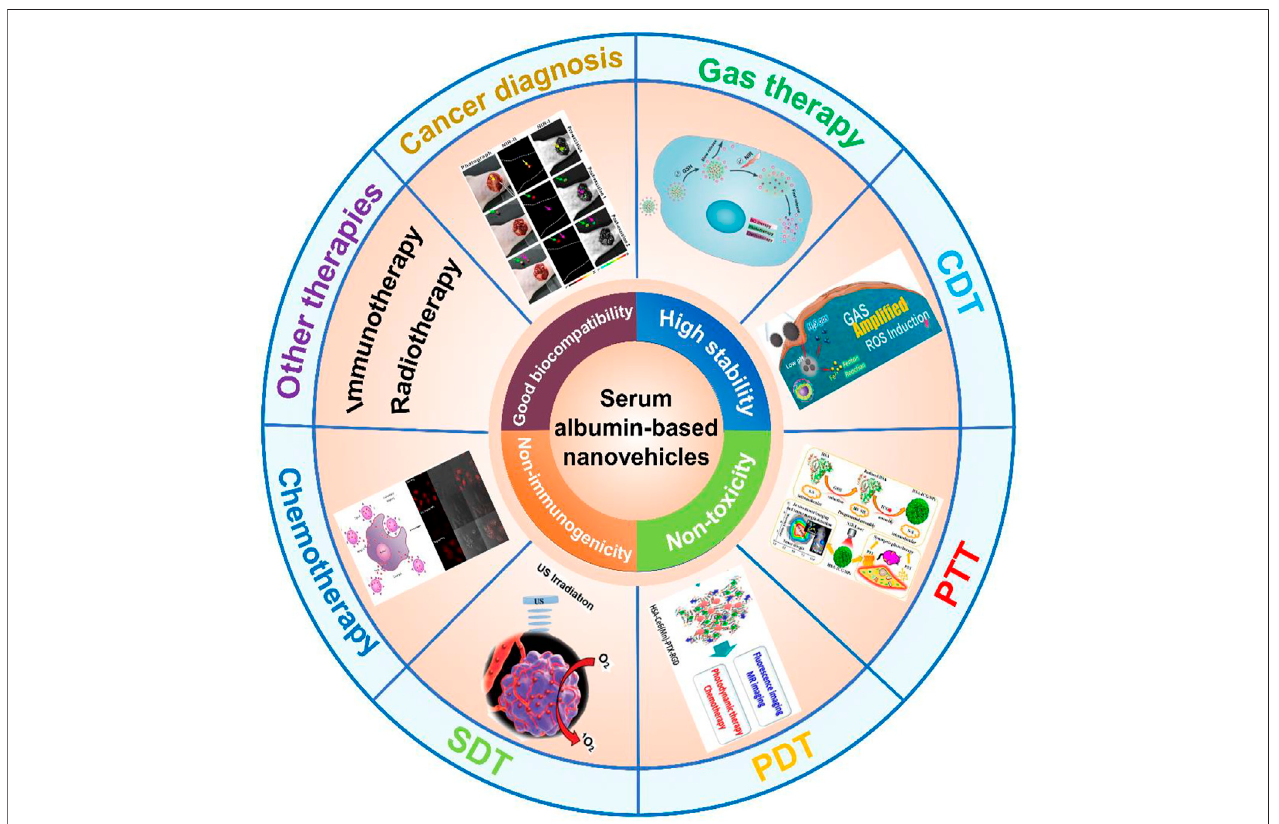
FIGURE 1 | The application of serum albumin-based nanovehicles in cancer diagnosis and therapy. Image for gas therapy: Reproduced with permission from Xu etal.(2019).Copyright2019,RoyalSocietyofChemistry.ImageforCDT:ReproducedwithpermissionfromXieetal.(2020).Copyright2020,WILEY-VCHVerlagGmbH and Co. KGaA, Weinheim. Image for PTT: Reproduced with permission from Sheng et al. (2014). Copyright 2014, American Chemical Society. Image for PDT: Reproduced with permission from Chen et al. (2015). Copyright 2015, American Chemical Society. Image for SDT: Reproduced with permission from Ma et al. (2019). Copyright 2018, WILEY-VCH Verlag GmbH and Co. KGaA, Weinheim. Image for chemotherapy: Reproduced with permission from Qi et al. (2015). Copyright 2015, American Chemical Society. Image for cancer diagnosis: Reproduced with permission from Zeng et al. (2020). Copyright 2020, American Chemical Society.